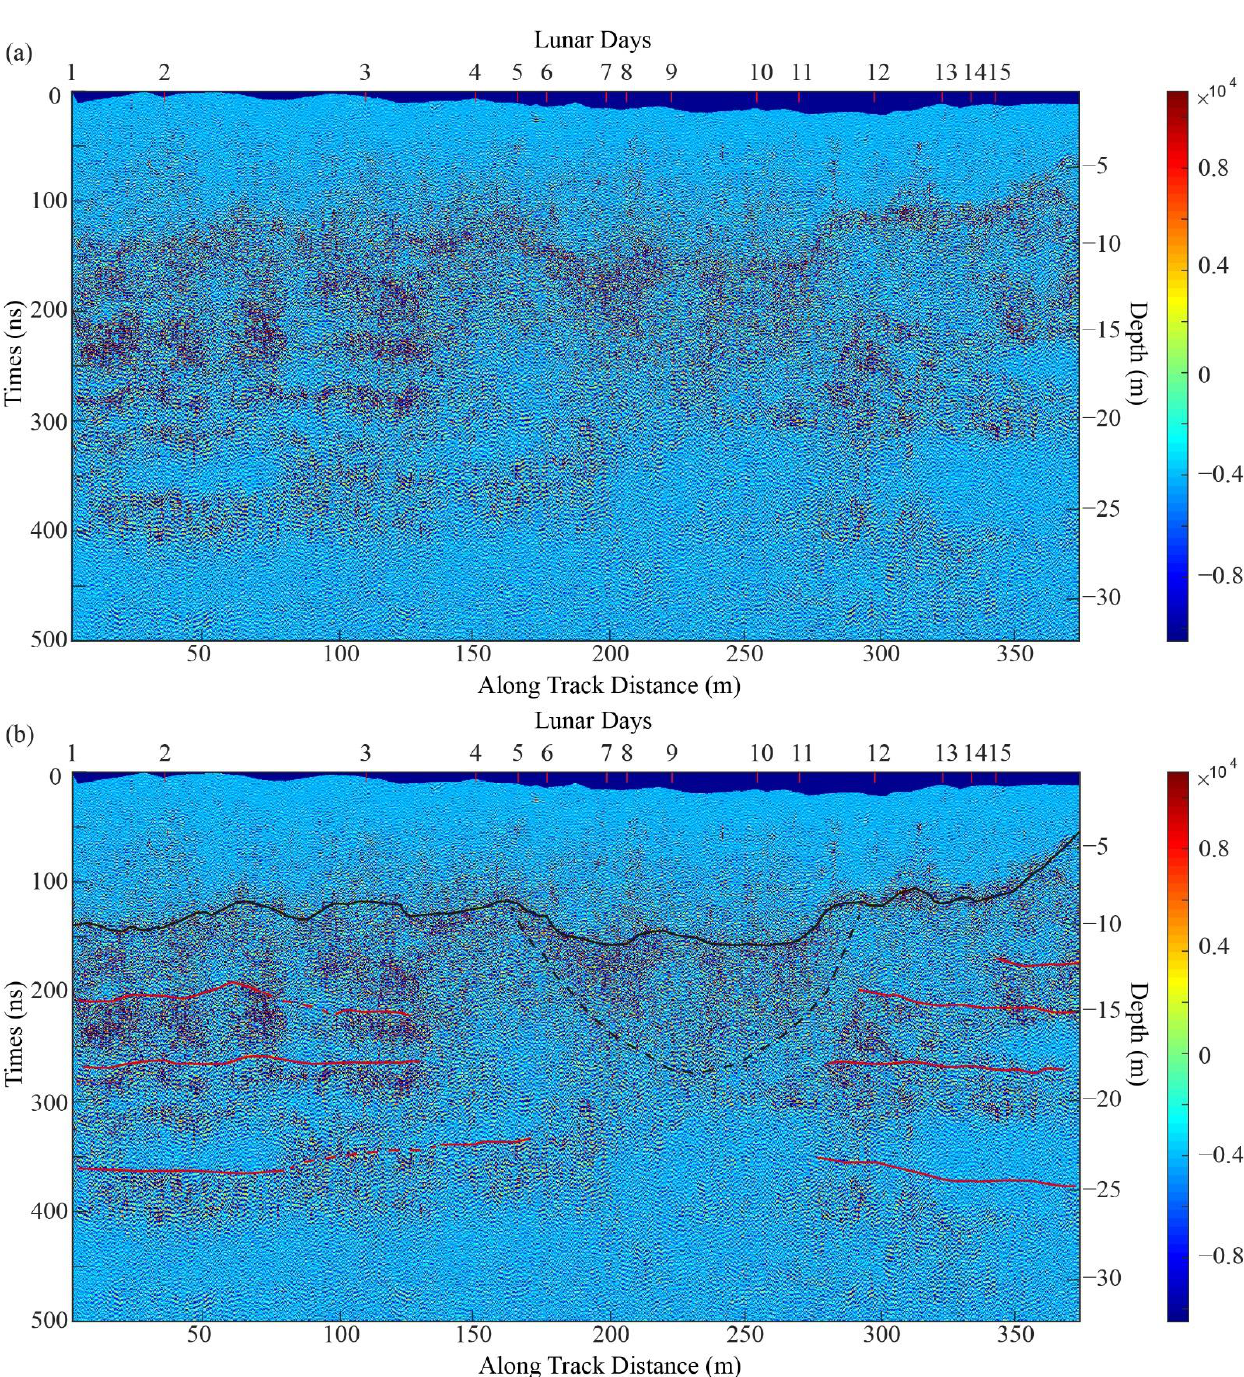
Figure 9. LPR data after migration and topographic correction. ( a ) The processed LPR image. ( b ) The LPR image with interpretation. The depth of the y-axis is converted with ε ̅ =4.3 ( τ≤154 ns), ε ̅ =6( τ >154 ns). The black solid line marks the interface reflector between the fine and coarse materials. Red solid lines show the internal layered interface of coarse-grained materials, while shows the possible internal layered interface of coarse-grained materials.